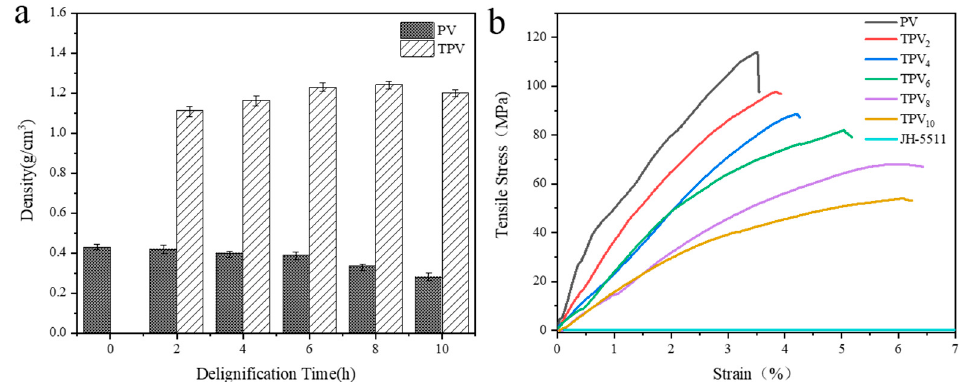
Figure 8. Density and stress-strain curves of PV and all TPVs. ( a ) Density diagram, ( b ) Stress strain curve.